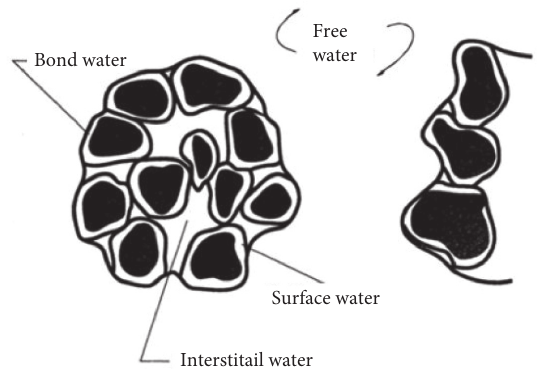
Figure 1: The moisture distribution in sludge [5].